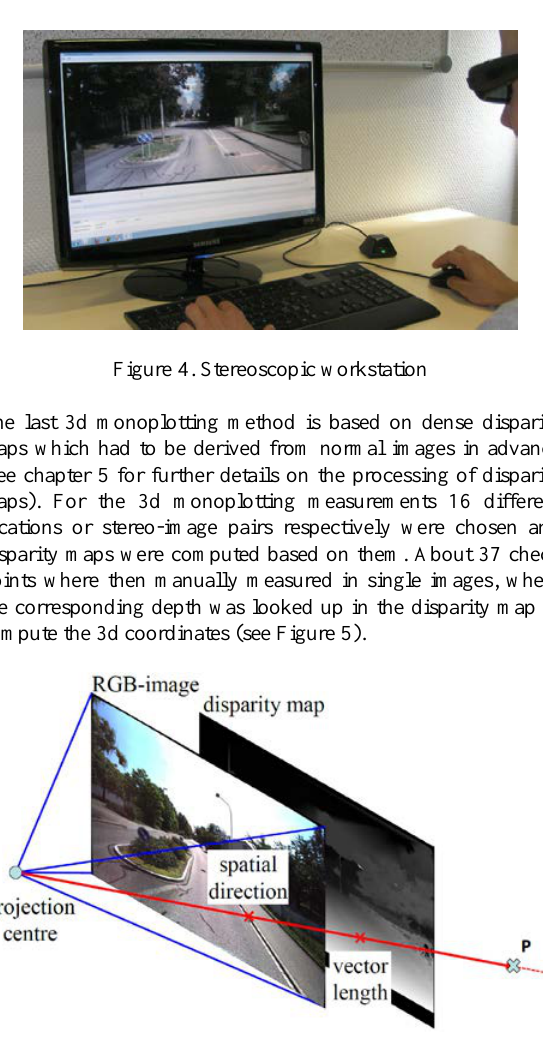
Figure 5. 3d monoplotting